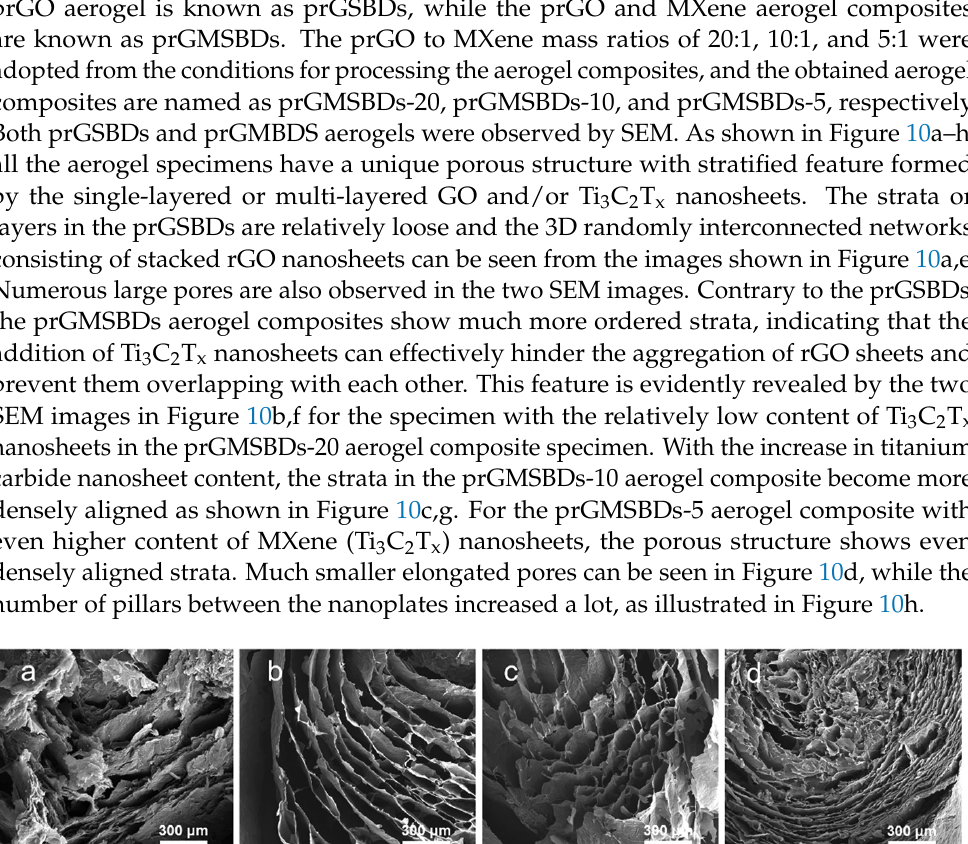
Figure 11. SEM images of the aerogel composites: ( a , e ) MFCAs, ( b , f ) HMFCA-1, ( c , g ) HMFCA-2, ( d , h ) HMFCA-3. Reprinted with permission from [25]. Copyright ©2016 American Chemical Soci- ety.